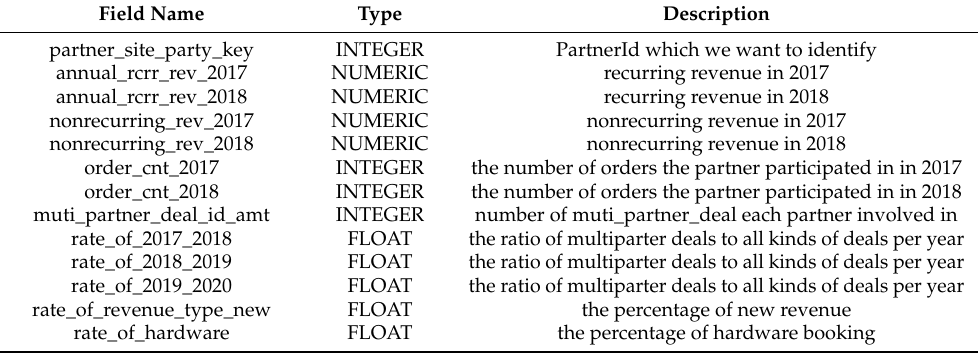
Table 2. Training dataset